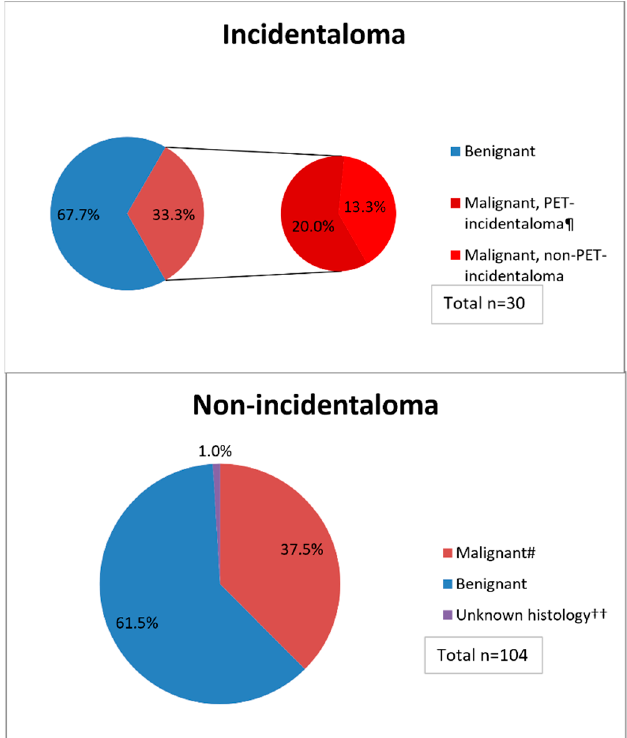
Figure 3. Proportion of malignant tumors within the patients who had surgery recommended. “¶” including 2 patients who had proven malignancy but did not receive surgery. # including 3 patients who had proven malignancy but did not receive surgery. †† including 1 patient who received surgery in a different hospital and 1 who refused surgery.